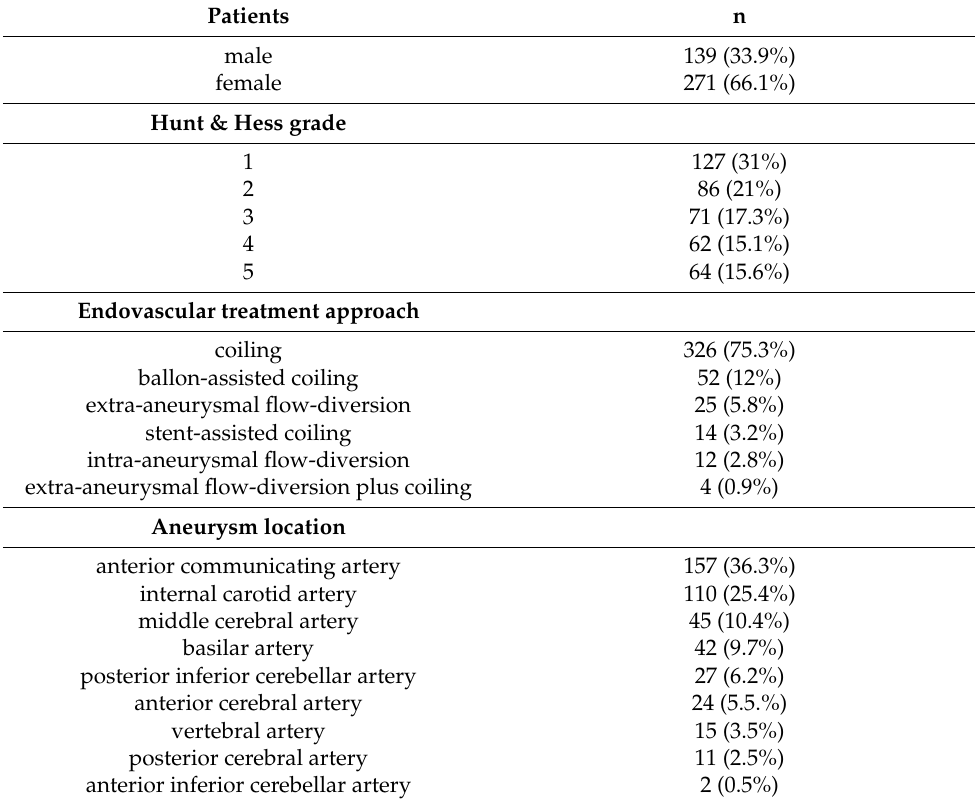
Table 1. Patient and aneurysm